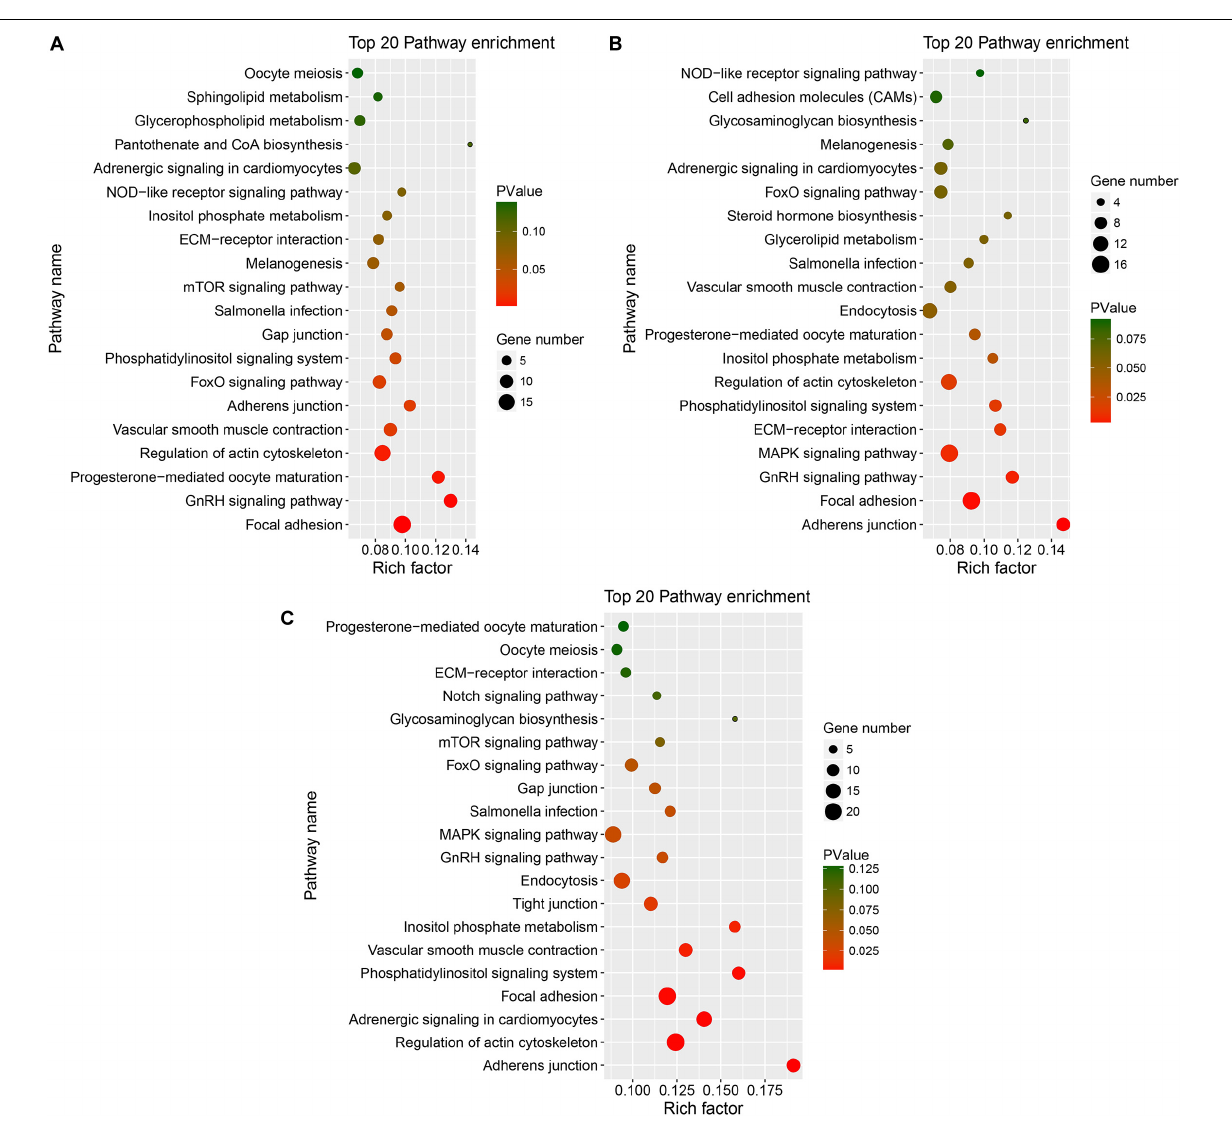
FIGURE 6 | KEGG of host genes of DE circRNAs in different comparison group. (A–C) represents Top 20 pathways for host genes of circRNAs for SYFG vs. SYFT, F6G vs. F6T, and F1G vs. F1T comparison group, respectively. DE, differentially expressed; SYF, small yellow follicle; F6, the smallest hierarchical follicle; F1, the largest hierarchical follicle. G, granulosa cell; T, theca